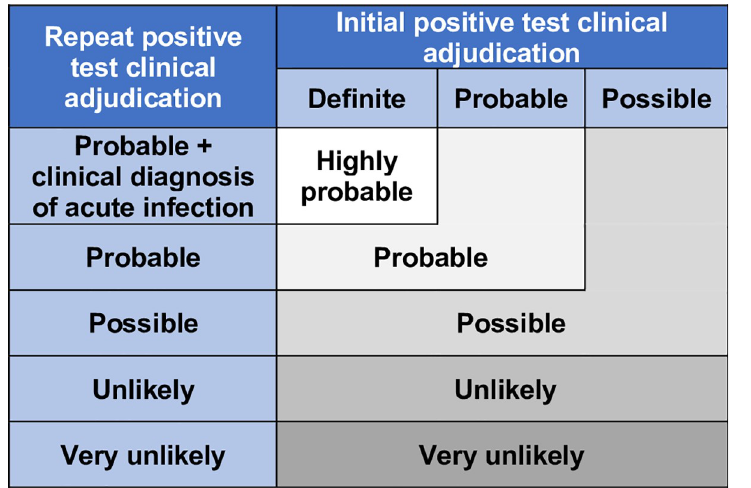
Fig 1. Algorithm for determining clinical likelihood of COVID-19 recurrence.